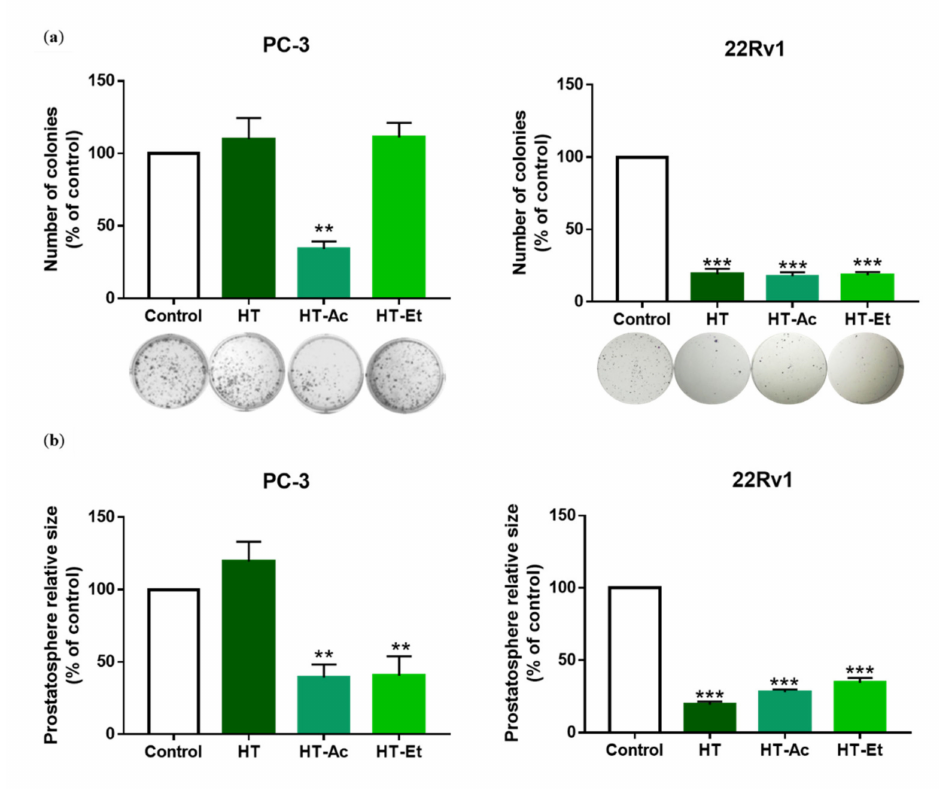
Figure 4. ( a ) Effect of HT, HT-Ac, and HT-Et treatment of PC-3 (20 µ M, 10 days) and 22Rv1 (10 µ M, 14 days) cells in the clonogenic assay. Data are expressed as number of colonies (percent of control, set at 100%) and rep- resent the mean ± SEM (4 experiments). Asterisks indicate significant differences compared to the control value: ** p < 0.01, *** p < 0.001; ( b ) Effect of HT, HT-Ac, and HT-Et treatment of PC-3 (20 µ M, 14 days) and 22Rv1 (10 µ M, 14 days) in the size of prostatospheres. Data represent the mean area ± SEM (4 experiments). Asterisks indicate significant differences to the control value: ** p < 0.01, *** p < 0.001. Abbreviations: HT, Hydroxytyrosol; HT-Ac, hydroxytyrosyl acetate; HT-Et, ethyl hydroxytyrosyl